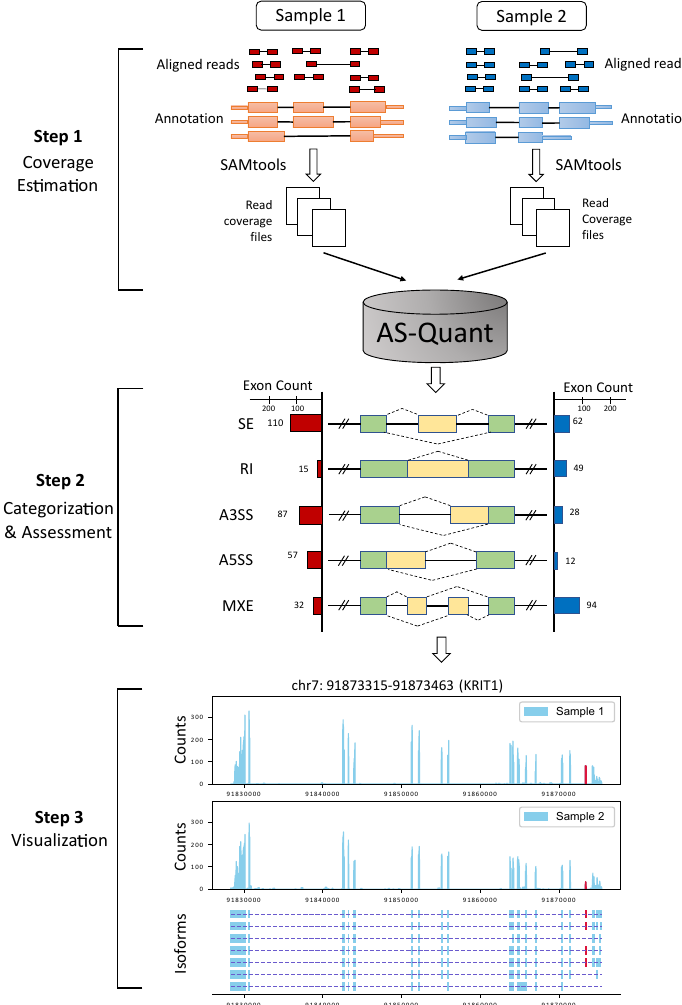
Figure 6. Workflow of AS-Quant. Starting with aligned RNA-seq bam files, AS-Quant consists of three steps (i) read coverage estimation, (ii) splicing events categorization and assessment, (iii)